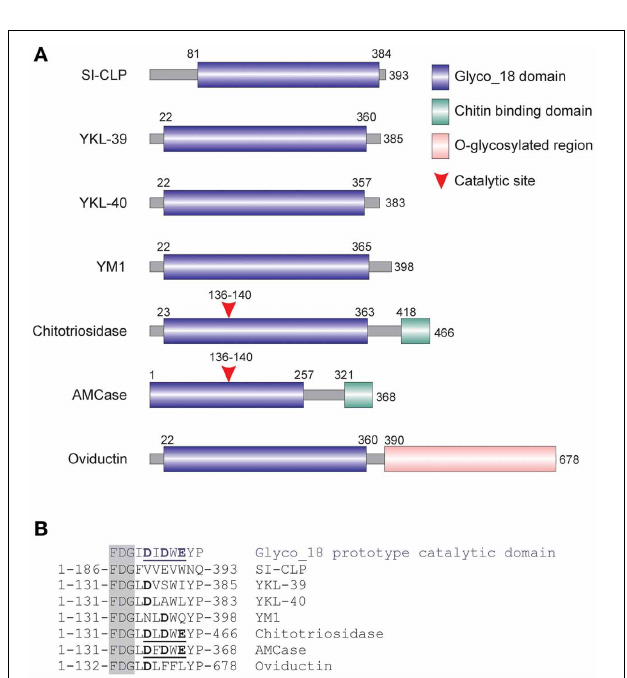
FIGURE 2 | Mammalian chitinase-like proteins (CLP) belong to the family of Glyc_18-containig proteins. (A) Schematic presentation of mammalian Glyco_18 domain containing proteins. (B) Critical amino acid in catalytic sites. The characteristic FDG sequence preceding the catalytic motif is shown in the shadowed box. Catalytic amino acids are shown in bold. Complete active catalytic motifs are underlined. This research was originally published in Blood . Kzhyshkowska et al. (2006c) © the American Society of